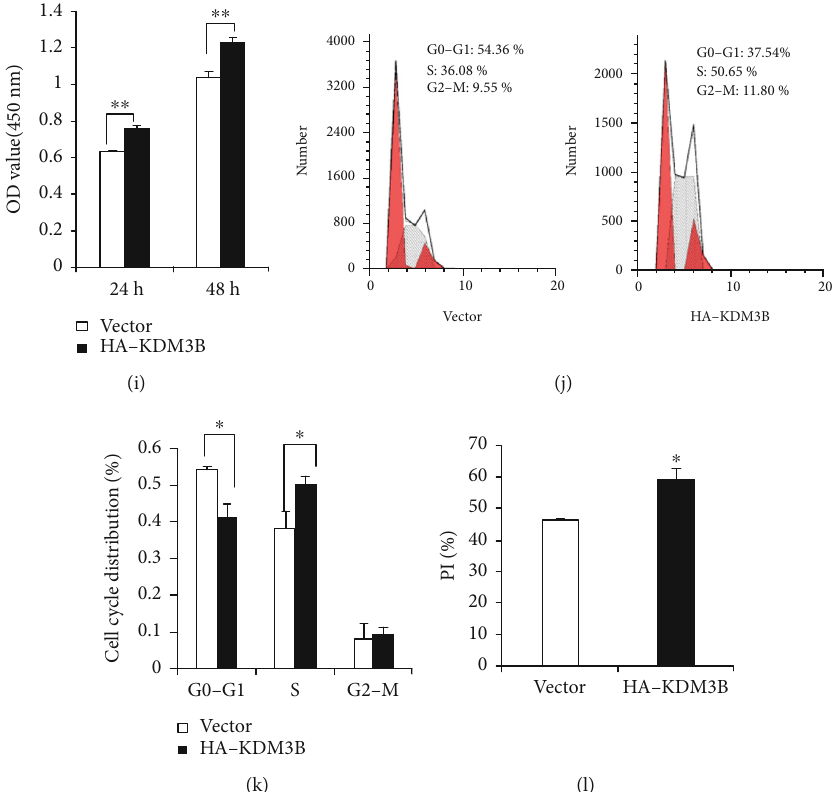
Figure 2: KDM3B enhanced the cell proliferation of SCAPs and regulated the cell cycle. The (a) CFSE assay and (b) quantitative analysis results revealed that KDM3B knockdown decreased the cell numbers at 3 days in SCAPs. (c) The CCK-8 assay revealed that KDM3B knockdown reduced the cell numbers at 24h and 48h in SCAPs. (d) Flow cytometric cell cycle analysis revealed that KDM3B knockdown increased the proportion of cells in the G0/G1 phase and decreased the proportion of cells in the S phase. (e) Comparison of cell cycle distribution between the KDM3B knockout group and the control group. (f) The proliferation index between the KDM3B knockout group and the control group. The (g) CFSE assay and (h) quantitative analysis results revealed that KDM3B overexpression enhanced the cell numbers at 3 days in SCAPs. (i) The CCK-8 assay revealed that KDM3B overexpression increased the cell numbers at 24 h and 48 h in SCAPs. (j) Flow cytometric cell cycle analysis revealed that KDM3B overexpression decreased the percentage of cells in the G0/G1 phase and increased the proportion of cells in the S phase. (k) Comparison of cell cycle distribution between the KDM3B overexpression group and the control group. (l) The proliferation index between the KDM3B overexpression group and the control group. Statistical signi fi cance was determined using Student ’ s t -test. All error bars represent SD ( n = 3 or 6). P < 0 : 05 . ∗∗ P ≤ 0 : 01